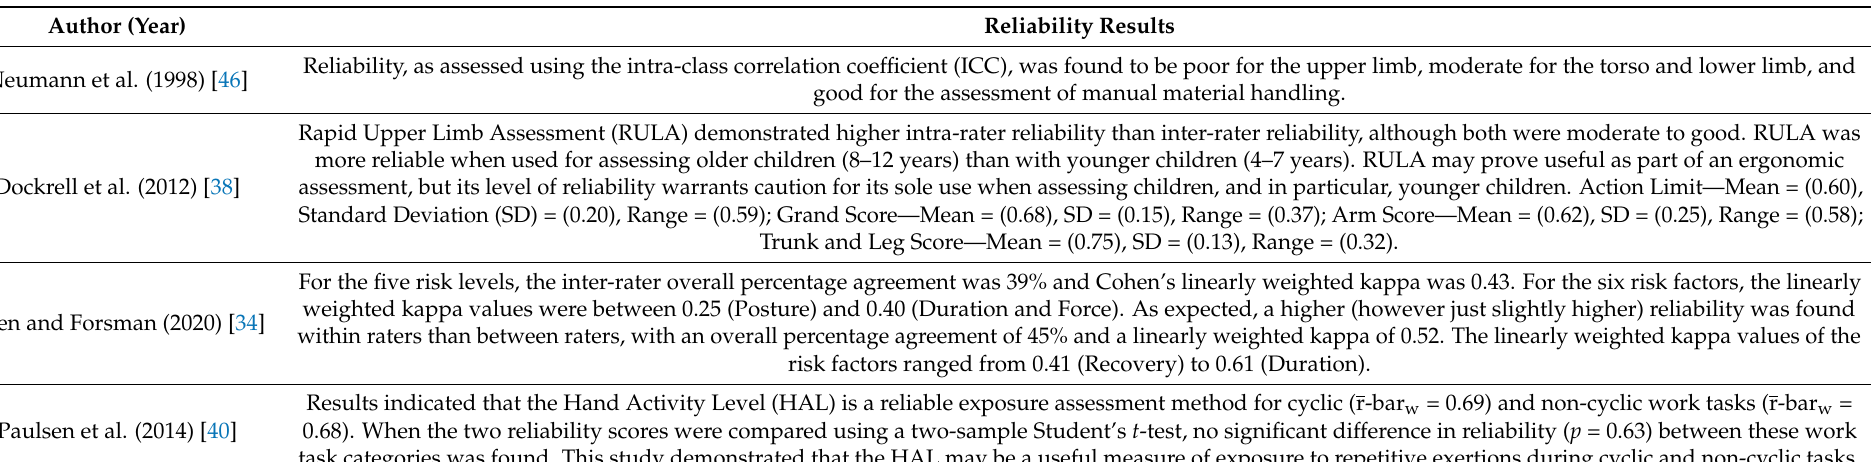
Table 4. Reliability results for the articles included in the review a